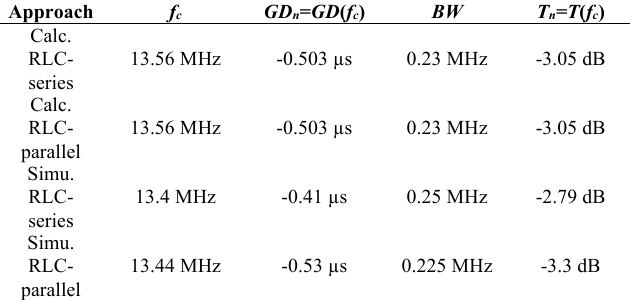
TABLE IV. Comparison of BP-NGD Prototype